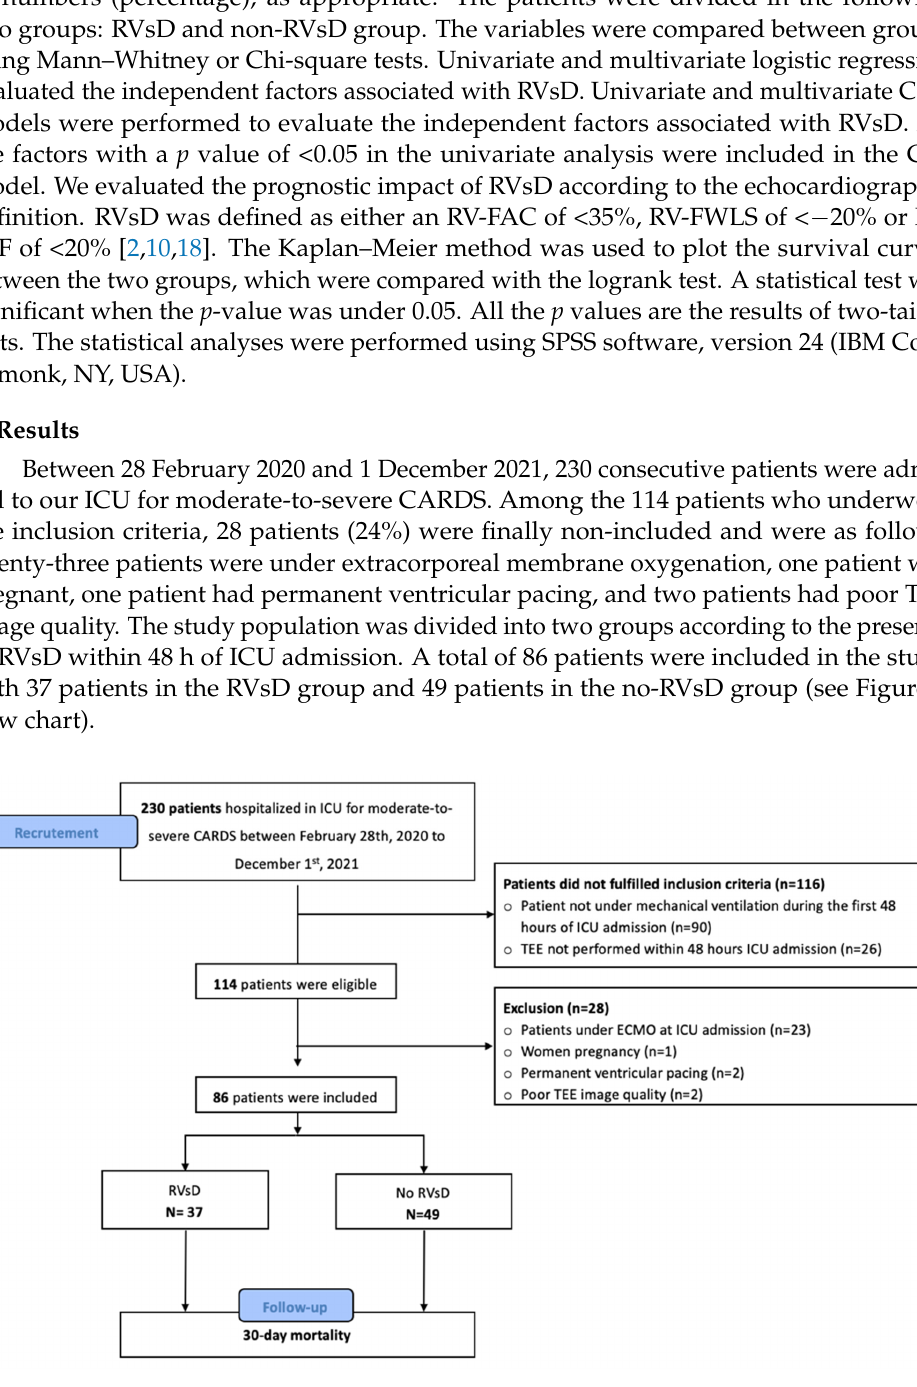
Figure 2. Flow chart of study population. CARDS: acute respiratory distress syndrome related to COVID-19 infection; ECMO: extracorporeal membrane oxygenation; ICU: intensive care unit; RVsD: right ventricular systolic dysfunction; TEE: transesophageal